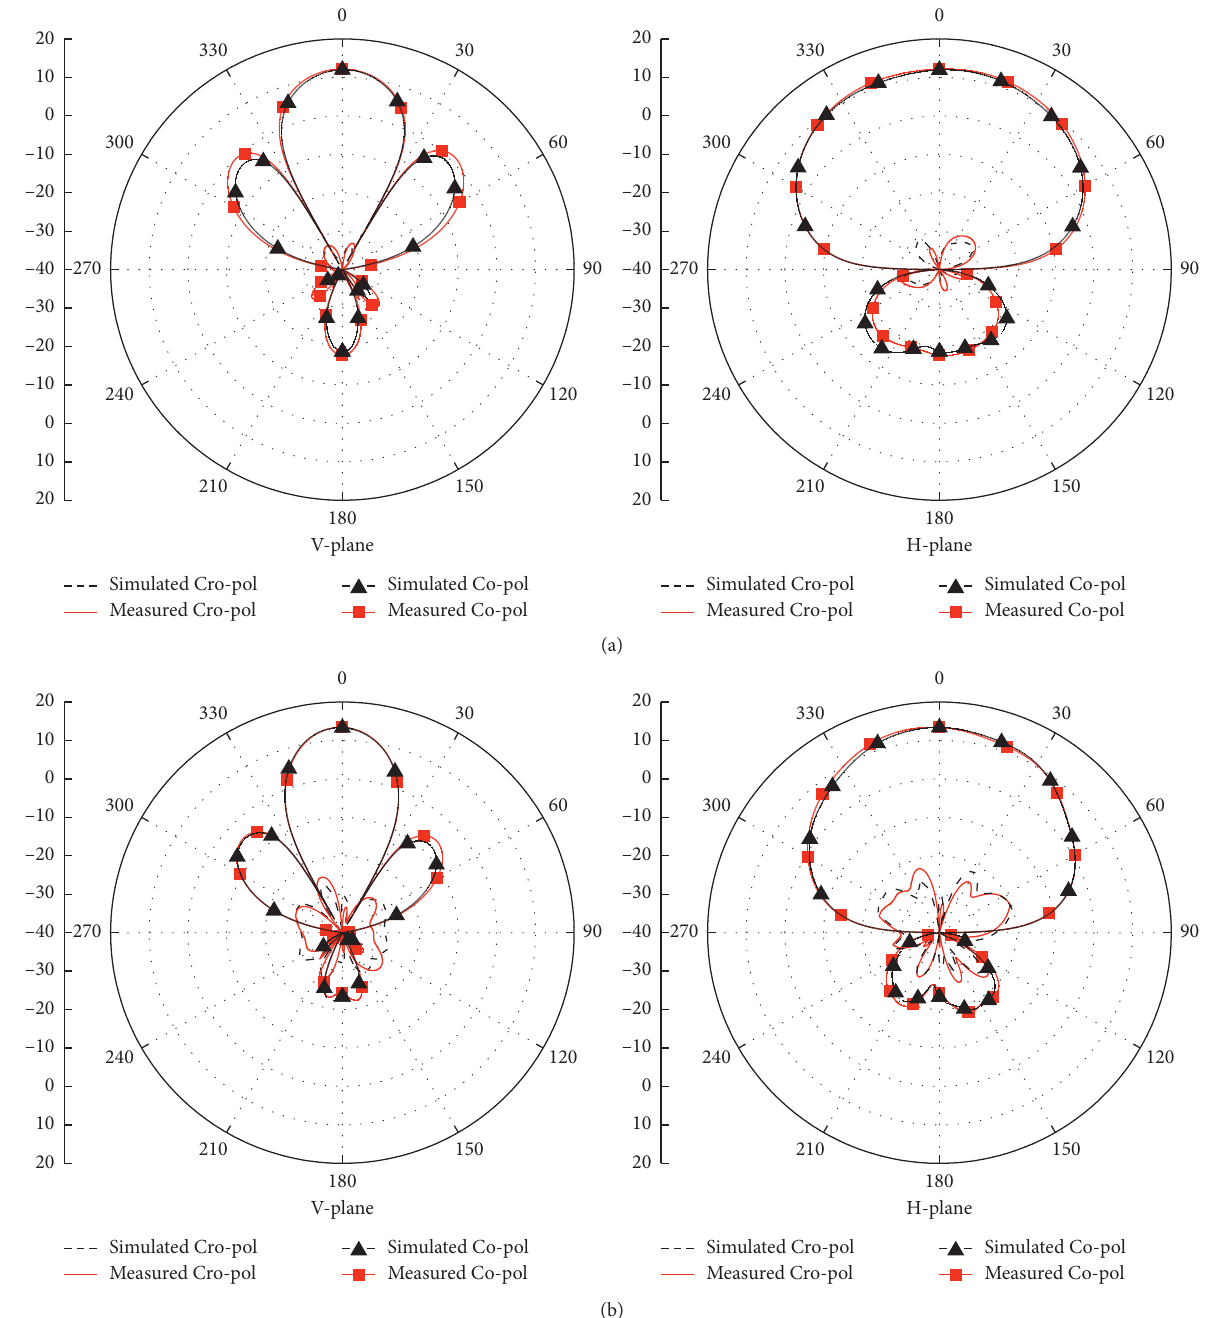
Figure 17: Simulated and measured radiation patterns of the antenna array at (a) 3.5 GHz and (b)